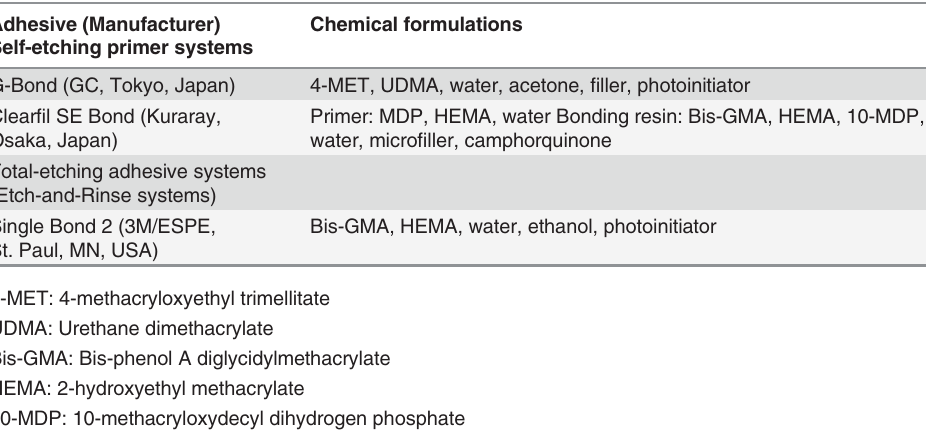
Table 1. Composition of the adhesive systems used in this study. Adhesive (Manufacturer)